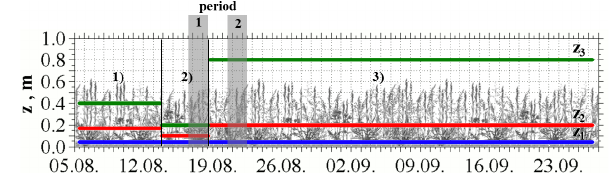
Fig. 3. Arrangement of the inlet heights ( z 1 – z 3 ) for the automated Tn and Rn profile measurements with respect to the canopy height h c . The periods 1 and 2 treated in the data evaluation are indicated. The measurement campaign was divided into three blocks: (1) 5– 13 August: z 1 = 0 . 04, z 2 = 0 . 17, z 3 = 0 . 40m; (2) 13–18